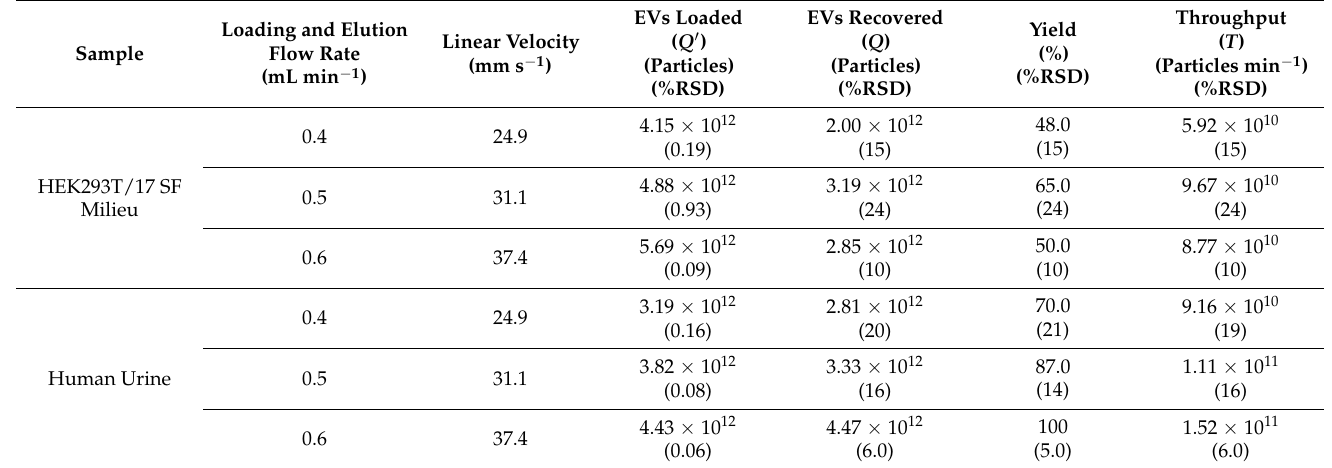
Table 1. Effects of varying the loading concentration of the HEK293T/17 SF cell milieu and human urine sample matrices on the loading, recovery, and yield of the capillary column. Precision noted as percent relative standard deviation (%RSD) for